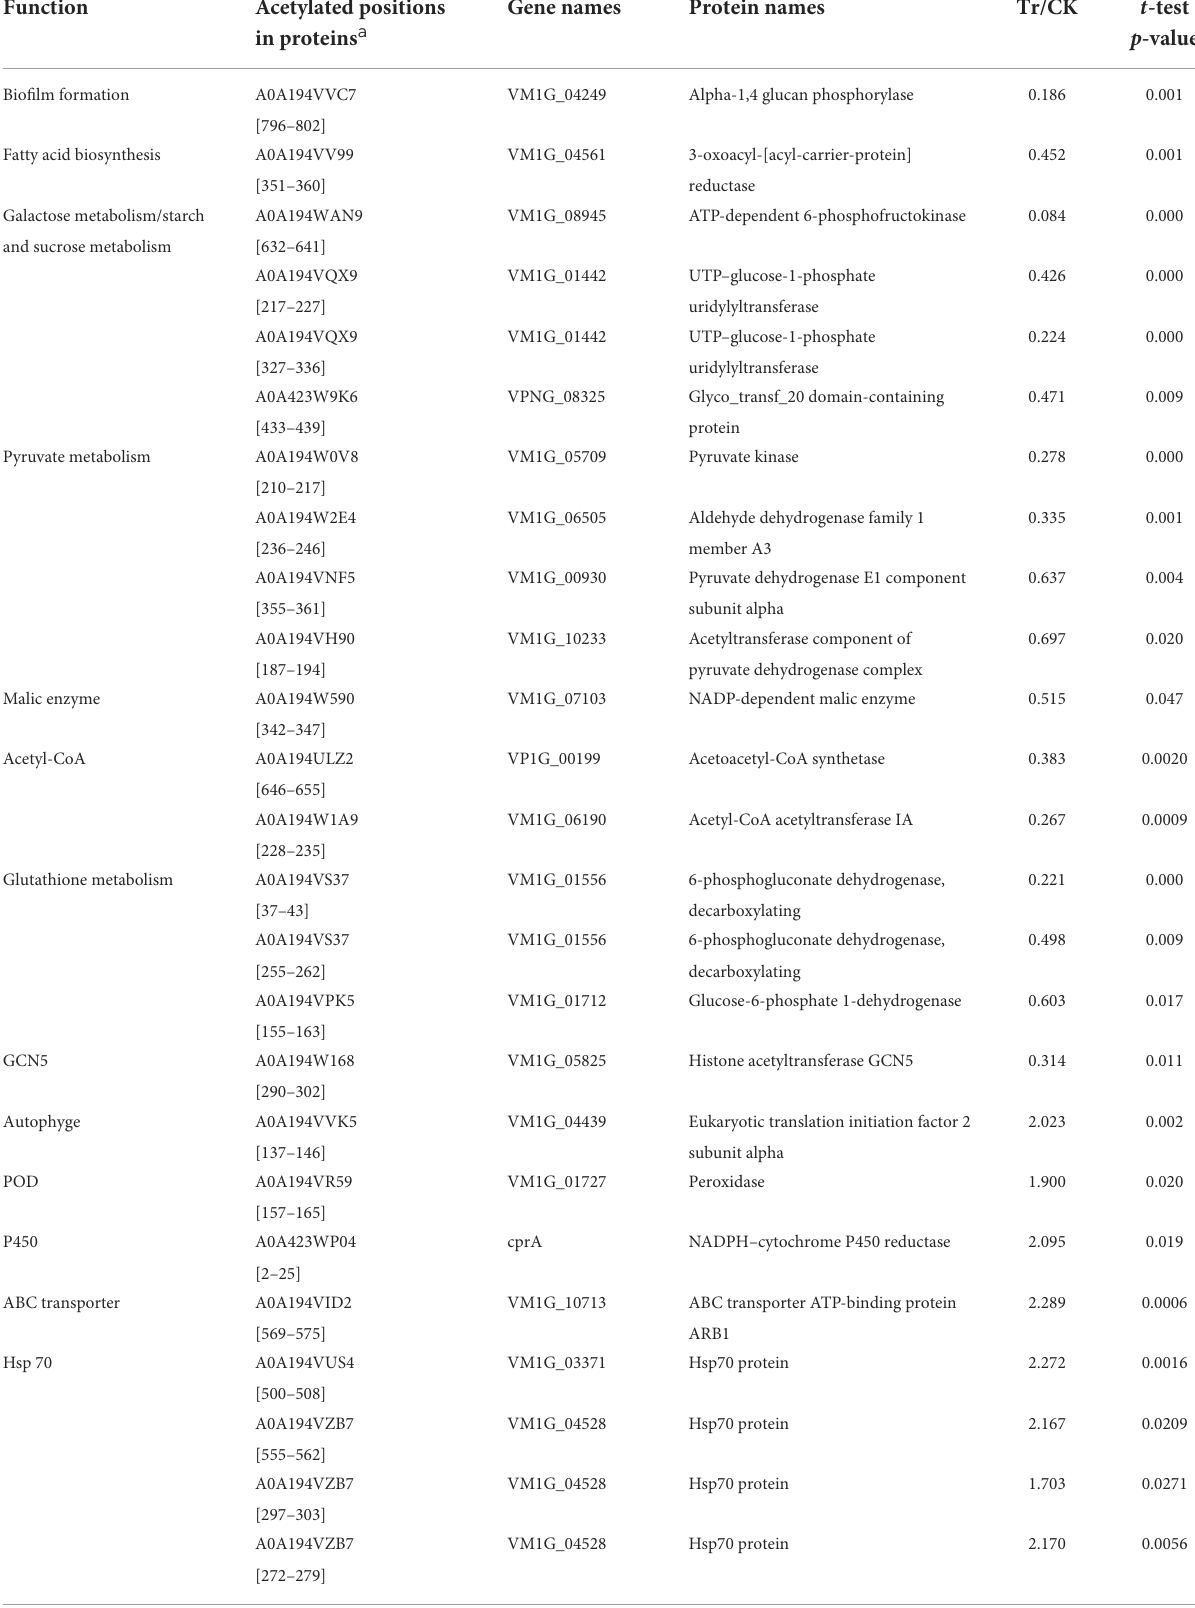
TABLE 3 List of acetylated proteins involved in the growth and pathogenicity of C. mali QH2 , and its response to B. velezensis